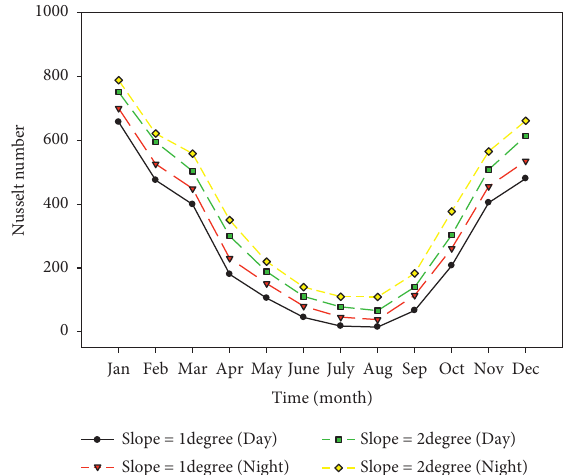
Figure 11: Effect of the inclination angle of the reactor on Nusselt number at Re � 9000, water depth � 5.6mm, and aspect ratio � 180.